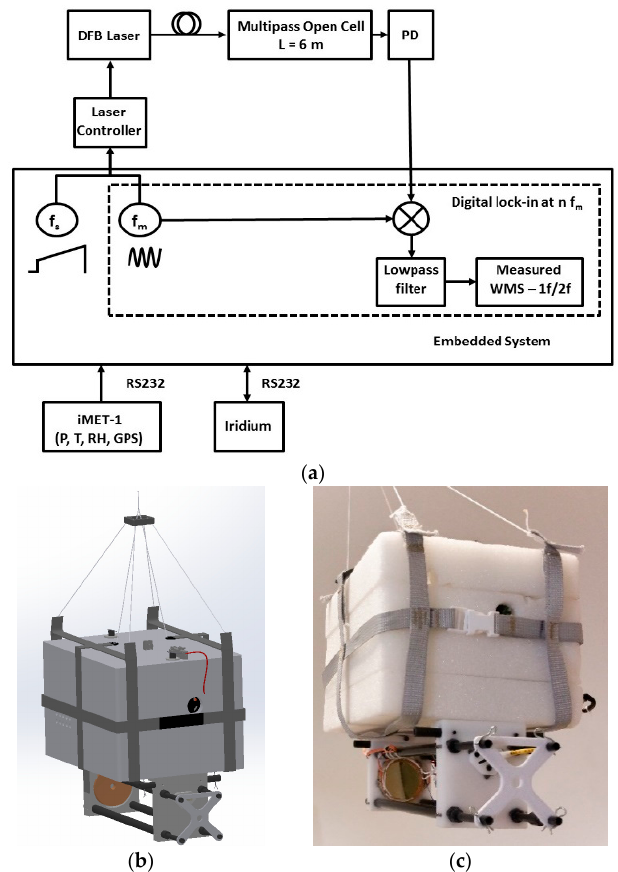
Figure 3. ( a ) Full schematic diagram of the developed AMULSE in the embedded system configuration; ( b ) 3D drawing of the final version of the AMULSE. The dimensions of this instrument are 290 × 175 × 227 mm; ( c ) Photography of the AMULSE taken after the measurement campaign.